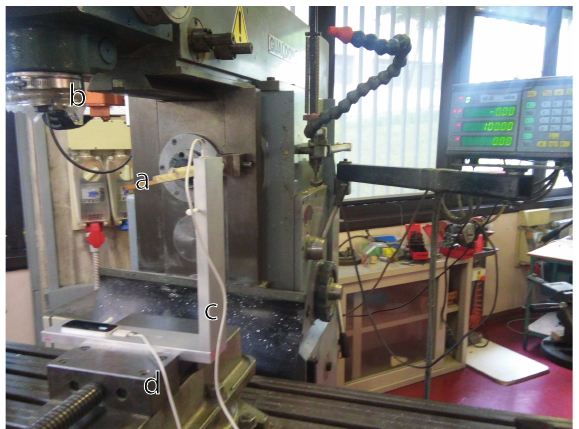
Figure 4. The mill equipped with the three axes movement system. The stick (a) was fixed to the static structure of the mill also hosting the mill tool (b). The VG structure (c) was secured by a grip to the three axes moving block of the mill (d), controlled numerically. The stick was used both to measure the LEAPs position with respect to the mill reference system and to collect spatial measurements inside the